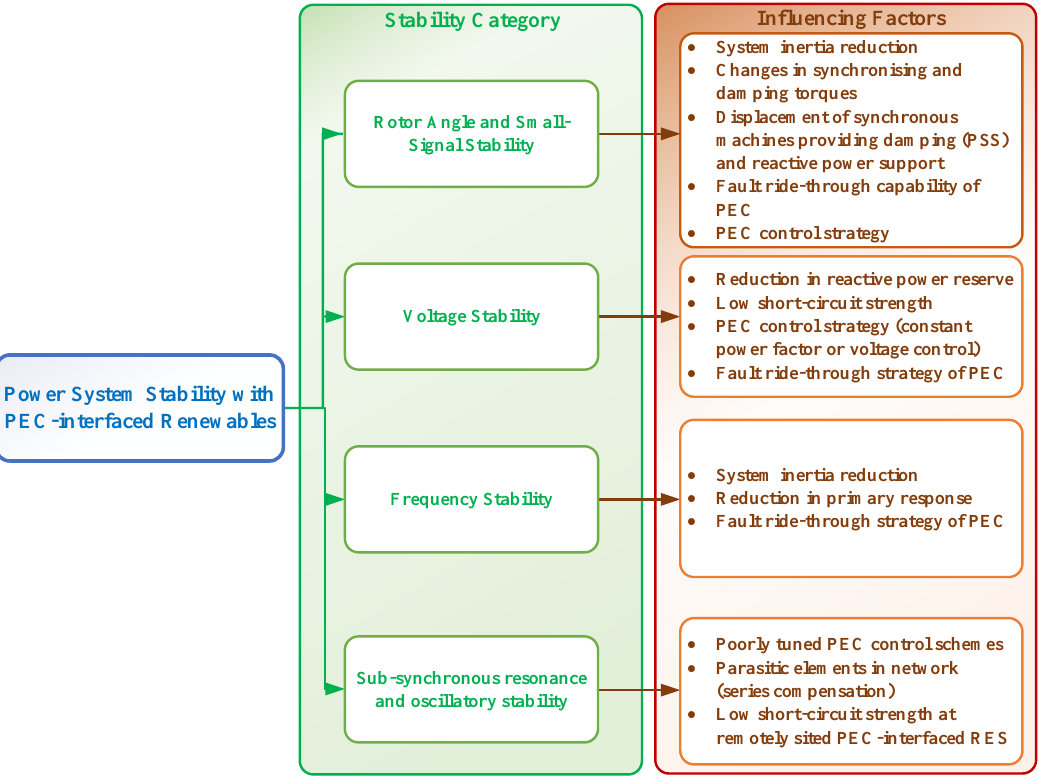
Figure 17. The key influencing factors of main stability categories with PEC-interfaced renewable generation.